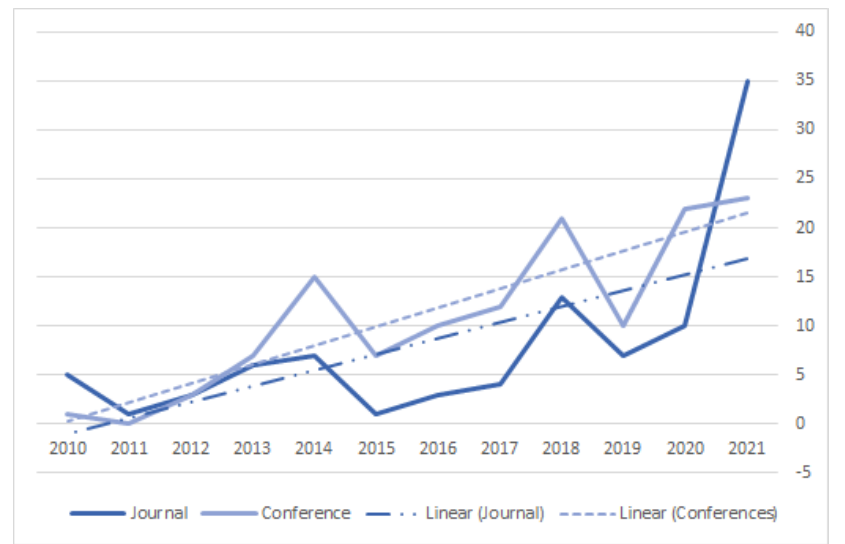
Figure 7. Distribution of the publications per year in function of the Source